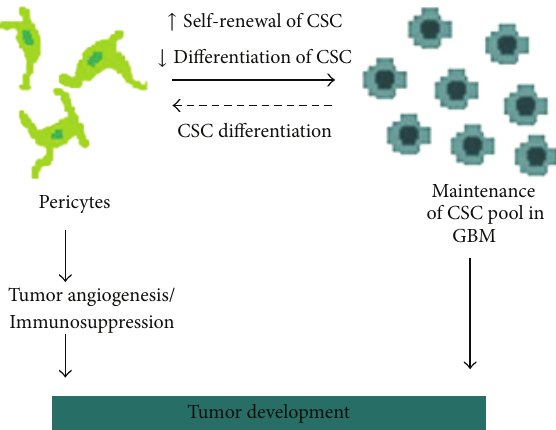
Figure 2: Interplay between pericytes and cancer stem cells. In brain cancer, the perivascular niche is critical to the maintenance of CSC pool. Perivascular cells promote self-renewal and impair differentiation of CSC. In turn, new pericytes may be generated by CSC, contributing to tumor angiogenesis and tumor scape from immune destruction. This reciprocal interaction between pericytes and CSC is highly beneficial to tumor